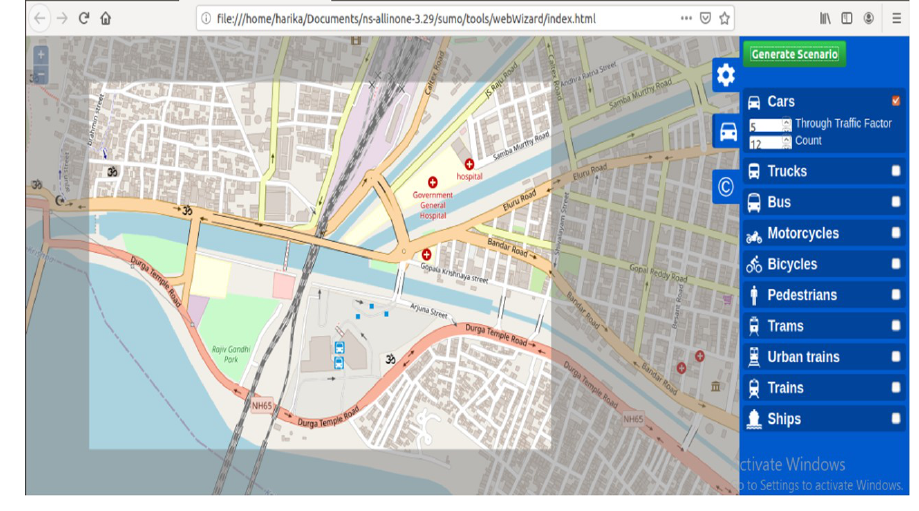
Figure 5. Open street map view.